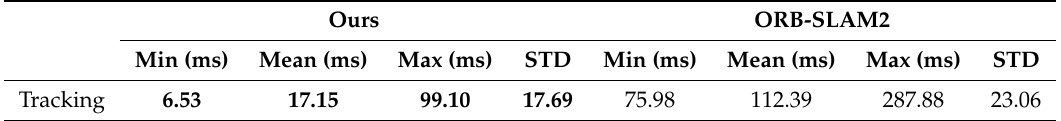
Figure 9. Comparison of tracking performances between our algorithm and ORB-SLAM2. The peak in our tracking time corresponds to the addition of keyframes, which need more time to extract features and match them, update the depth of keypoints, and optimize camera pose. Table 2. Time statistics for the detection of 2000 keypoints in the